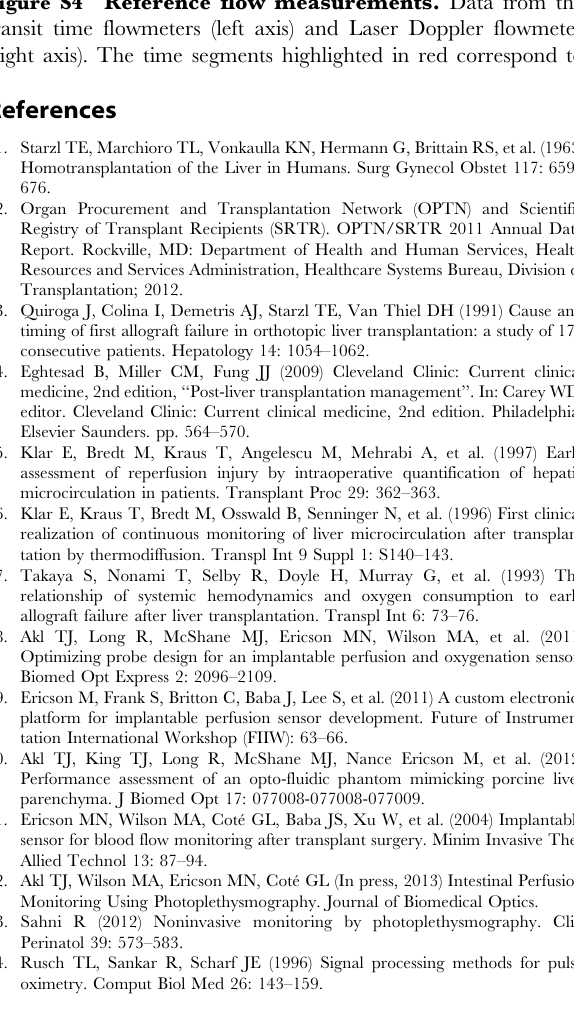
occlusion studies. (TIF) Figure S5 Oximetry catheters’ data. Arterial and venous oxygen saturation from experiment 1 (left) and 2 (right). (TIF) Figure S6 Comparison of the measured hemoglobin oxygenation index ( D HbD) to the arterial and venous oxygen saturation levels. (Left) Correlation between D HbD and the measured oxygenation levels. (Right) Calibrated D HbD can predict SvO2 with a higher degree of confidence (R2= 0.99) when using a multiple linear regression taking account for both supply and venous oxygenation. (TIF) Figure S7 Total hemoglobin concentration ( D HbT) as measured by the hepatic artery probe. (TIF) Supporting Information